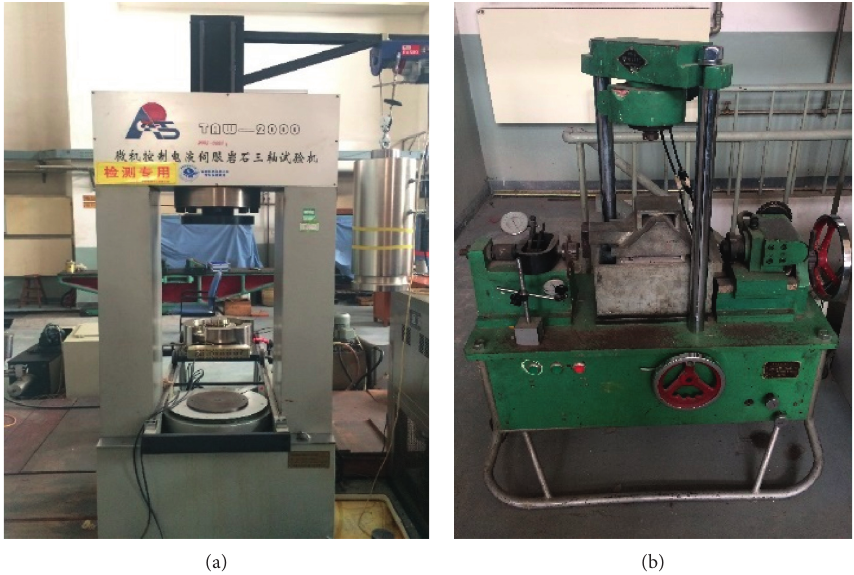
Figure 8: Mechanical test equipment: (a) uniaxial and triaxial compression test (TAW-2000); (b) direct shear test (XYJ-1).